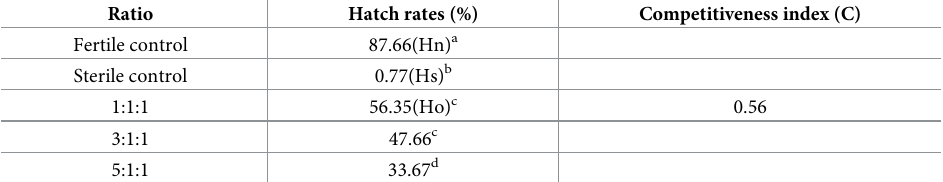
Table 1. Competitiveness index (C) of sterile Ae . aegypti males under laboratory conditions measured with differ- ent ratios of sterile to untreated males. Hatch rates (%) of females as a function of the different ratios (sterile males: untreated males: virgin untreated females). Different letters indicate significant differences between the ratios (Tukey’s posthoc test P < 0.05). Hn and Hs are the hatch rate from eggs of females mated with untreated (untreated control) or sterile (sterile control) males respectively. Ho is the observed egg hatch rate for each ratio.